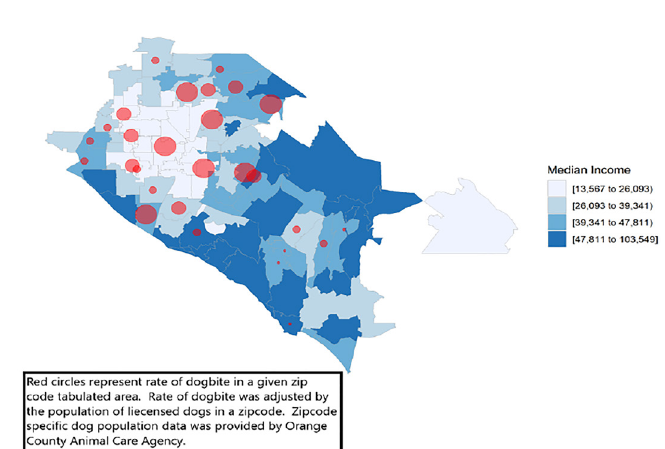
Figure 4. Distribution of dog bite injuries based on zip code and median income quartile.